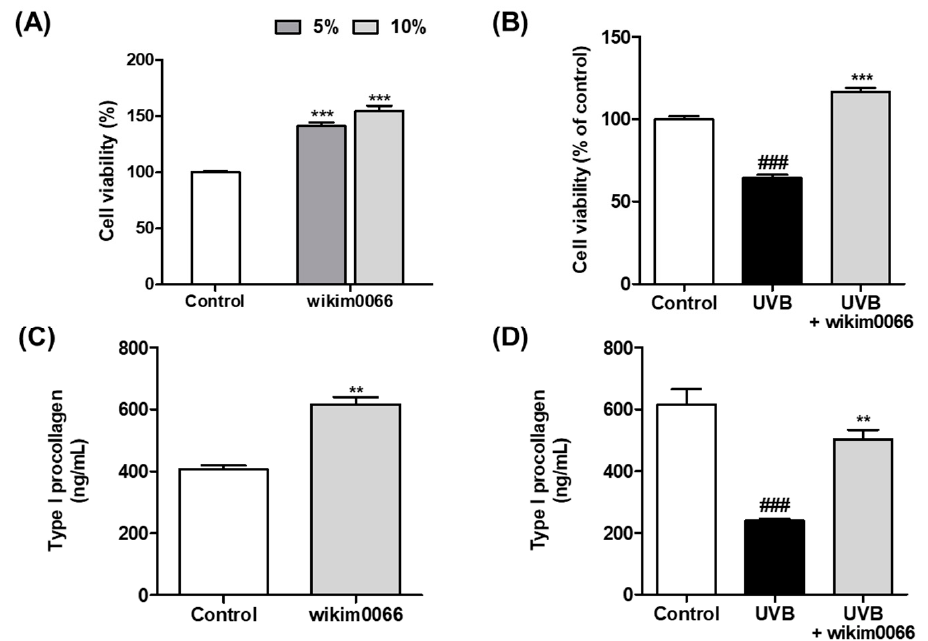
Figure 1. Effects of CFS from wikim0066 on cell viability and type I procollagen in UVB-irradiated Hs68 cells. Cell viability of only CFS treatment ( A ), CFS treatment with UVB irradiation ( B ), pro- duction of type I procollagen of only CFS treatment ( C ), and CFS treatment with UVB irradiation ( D ). Cultured Hs68 cells were pre-treated with 10% CFS for 24 h. After UVB (30 mJ/cm 2 ) irradiation, cells were immediately treated with fresh medium containing 10% CFS for 24 h. Cell viability was confirmed by MTT assay. The results are expressed as mean ± SEM ( n = 3). ### p < 0.001 vs. control and ** p < 0.01 and *** p < 0.001 vs.